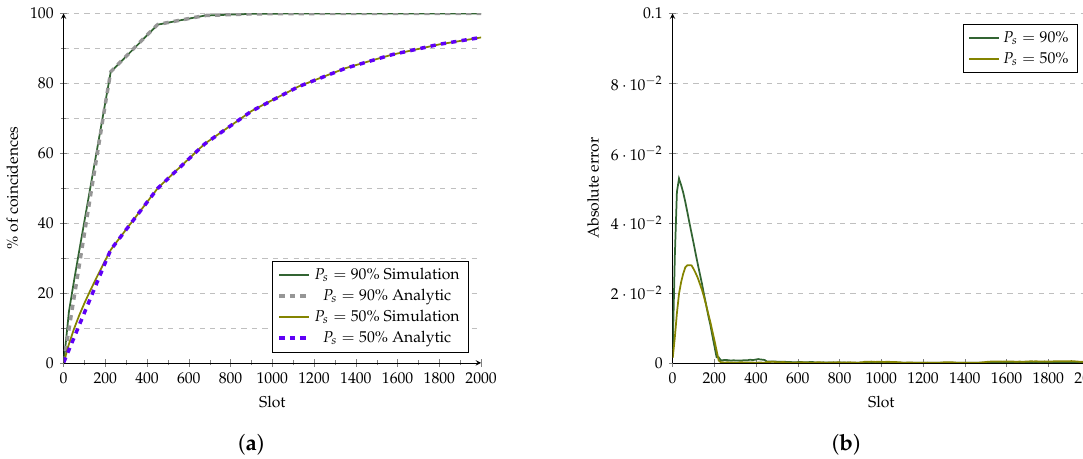
Figure 13. Evaluation of Hello’s analytic model at 10% duty cycle. ( a ) Analytic model vs. simulations. ( b ) Error of the analytic